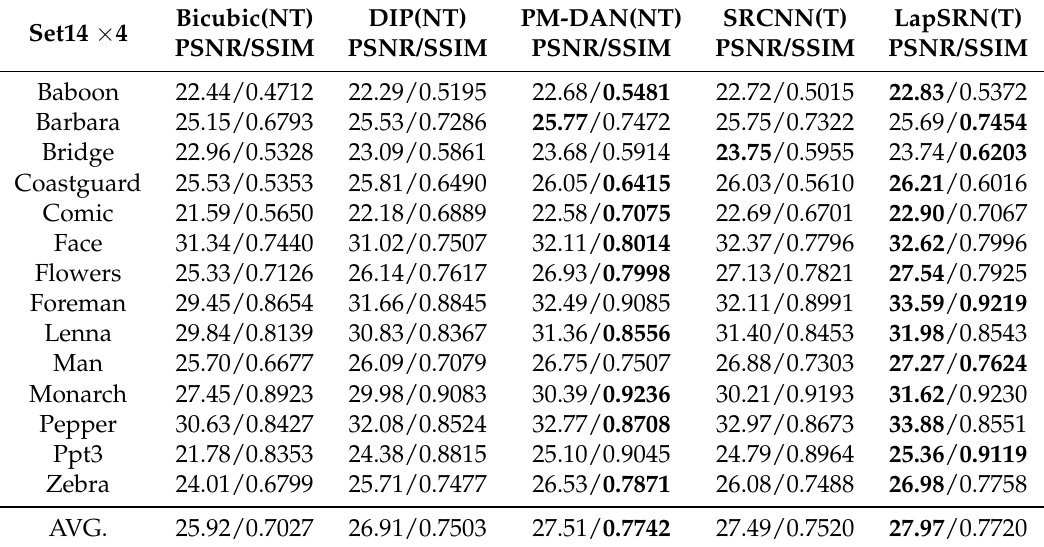
Table 5. 4 × SR comparison on Set14. The best PSNR and SSIM values are highlighted in bold. Set14 × 4